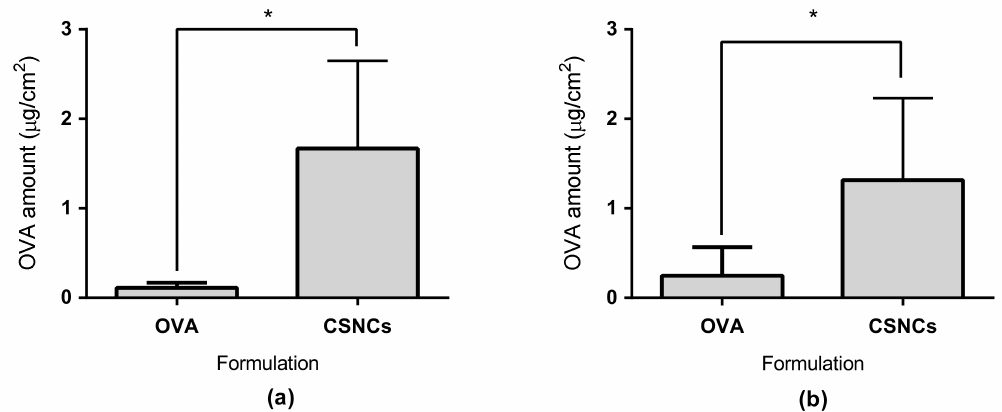
Figure 6. Ex vivo ovalbumin (OVA) transdermal penetration studies. ( a ) Amount of OVA absorbed through the skin after 24 h; ( b ) Amount of OVA retained in the skin after 24 h of experiment. CSNCs = chitosan nanocapsules. Values shown are mean ± SD ( n = 6). * statistically significant p ≤